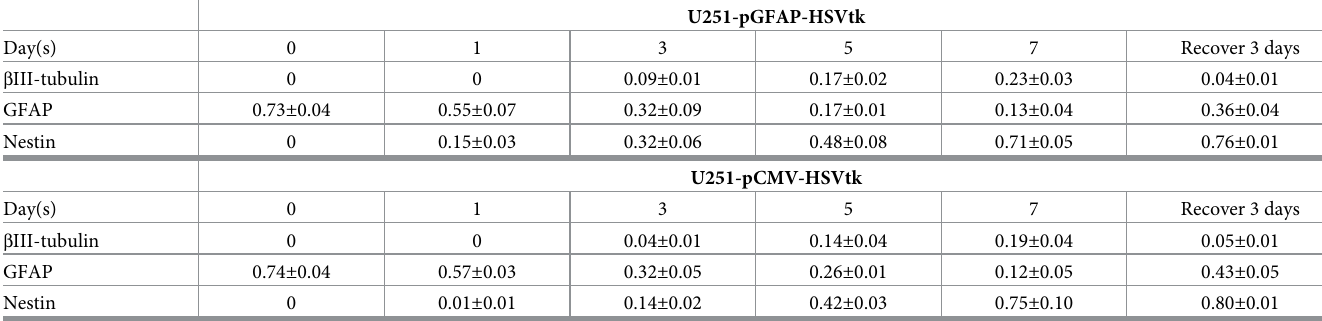
Table 1. Summary of differentiation rate of β III-tubulin, GFAP, and nestin during GCV